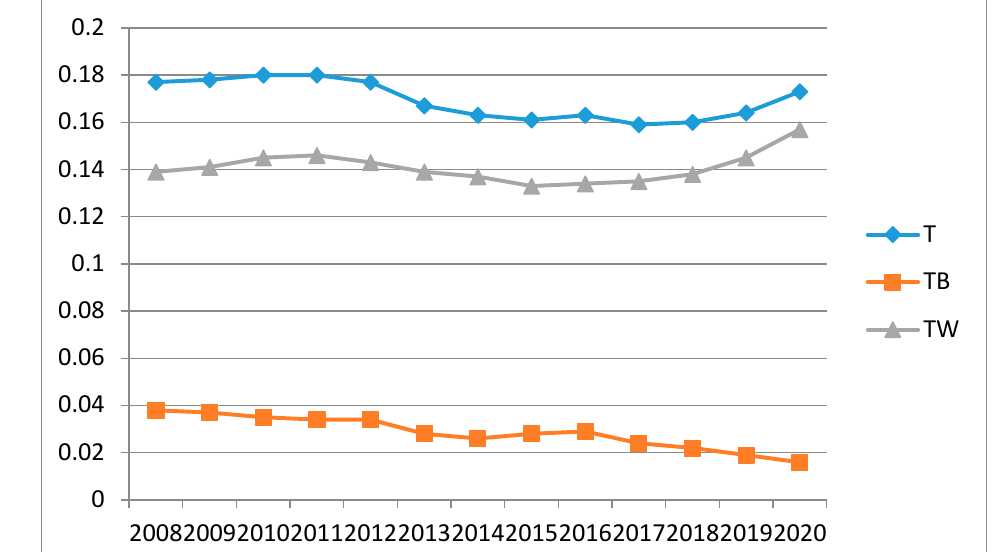
Figure 2. Trend of Theil index of transportation industry CEE.